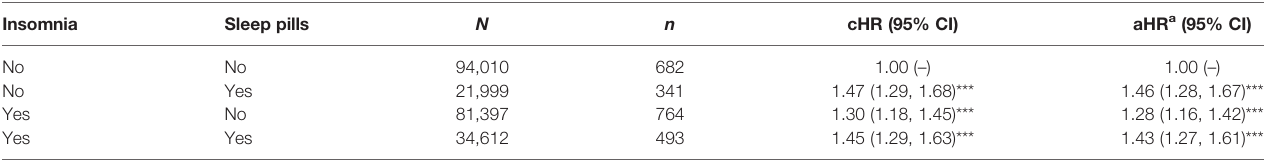
TABLE 8 | The effect of sleep pills on breast cancer in insomnia cohort.